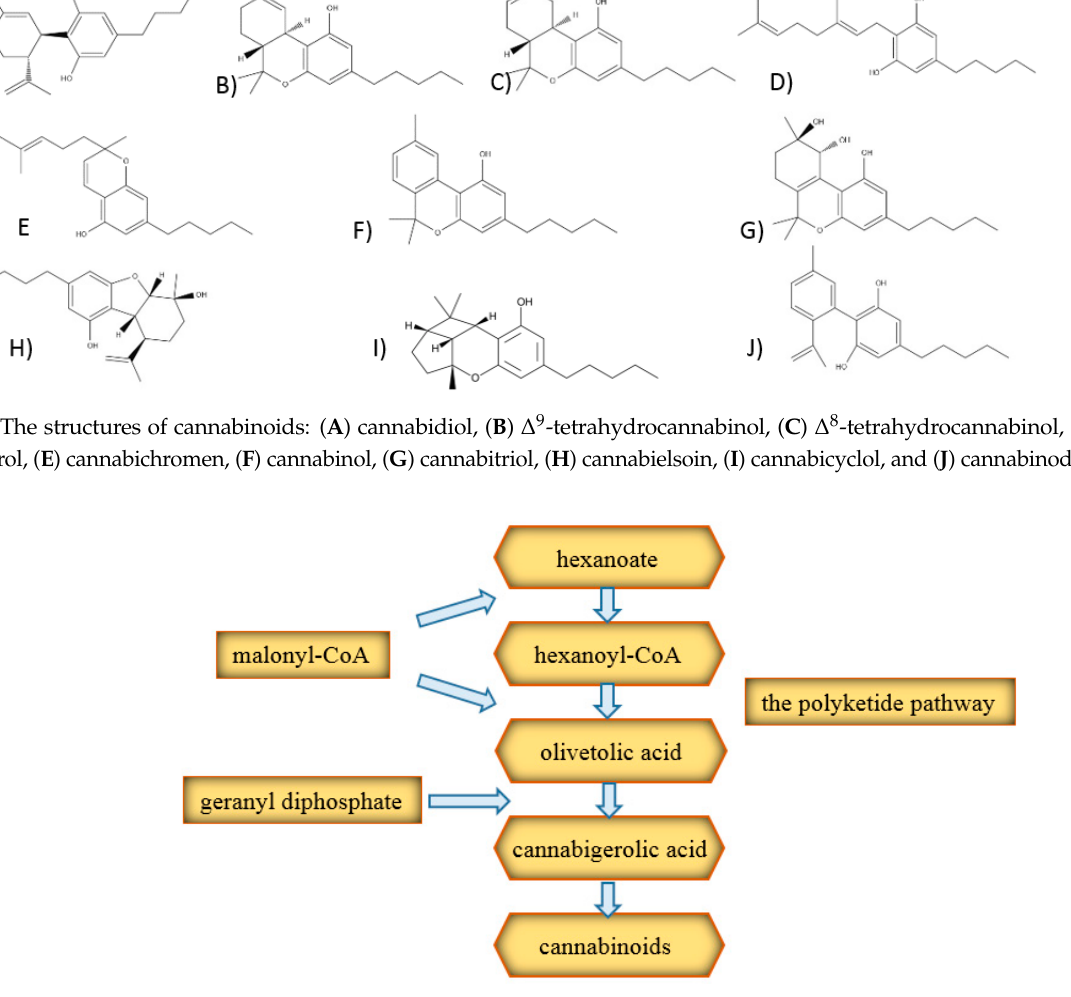
Figure 3. The structures of cannabinoids: ( A ) cannabidiol, ( B ) Δ 9 -tetrahydrocannabinol, ( C ) Δ 8 -tetrahydrocannabinol, ( D ) cannabigerol, ( E ) cannabichromen, ( F ) cannabinol, ( G ) cannabitriol, ( H ) cannabielsoin, ( I ) cannabicyclol, and ( J ) canna-